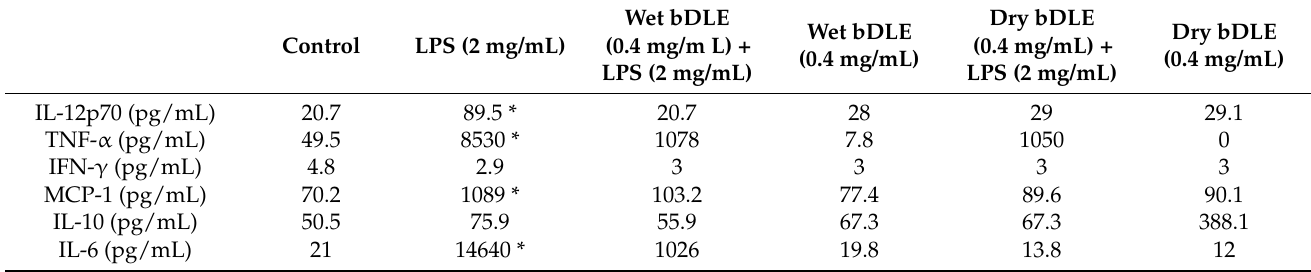
Table 5. Cytokine levels in LPS stimulated murine macrophages treated with wet and dry bDLE.